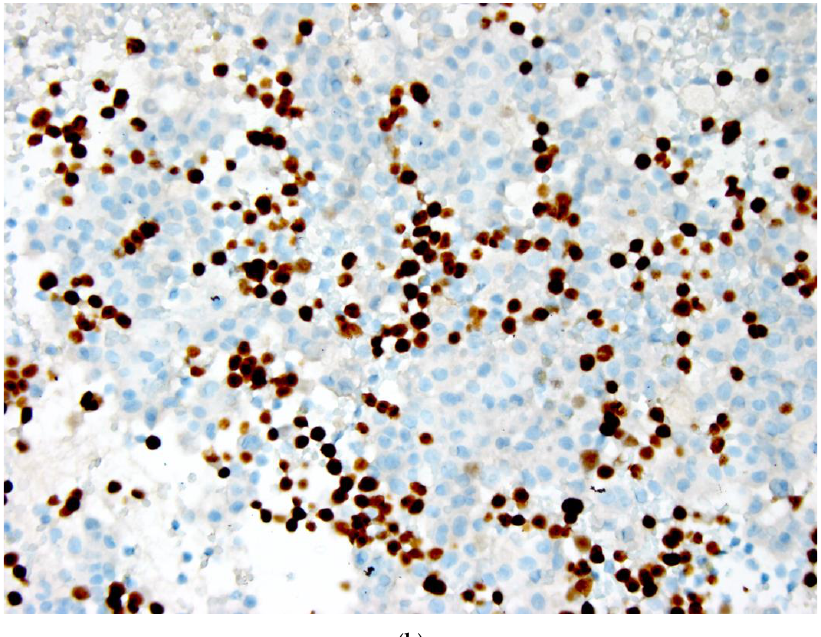
Figure 2. ( a ) Cytology ThinPrep of a pleural effusion aspirate shows metastatic lobular carcinoma (Papanicolaou stain). There are scattered dyscohesive tumor cells that are slightly larger than the surrounding mesothelial cells and lymphocytes. ( b ) Cytology cell block of a pleural effusion aspirate shows metastatic lobular carcinoma that is positive for estrogen receptor protein (immunohistochem- ical stain).